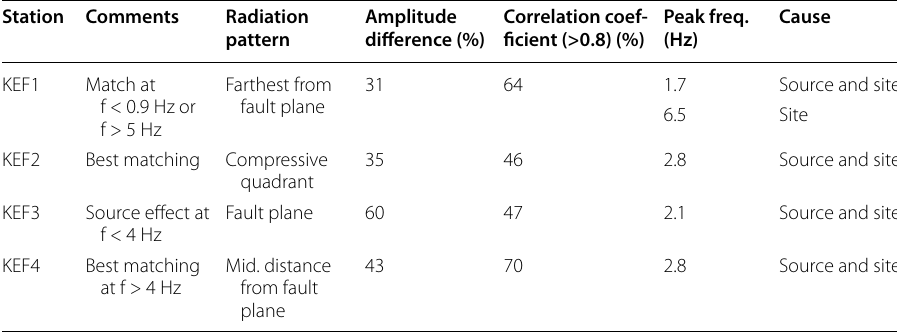
Table 4 Summary and interpretation of the comparison between weak earthquake and ambient noise data with respect to the theoretical seismic energy radiation pattern deduced from moment tensors of the 2014 Cephalonia earthquake sequence (see Fig.